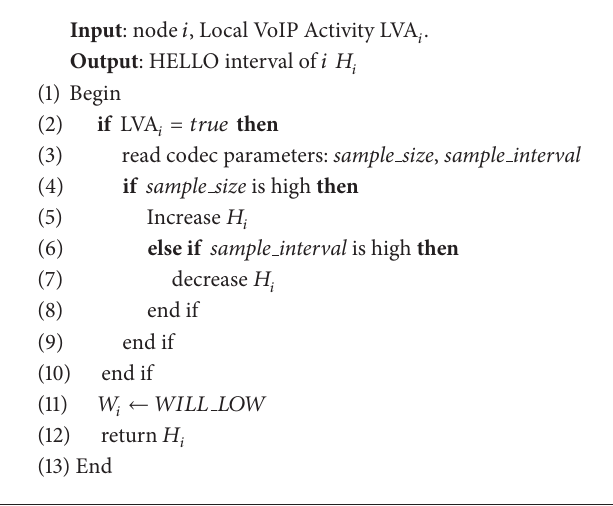
Algorithm 1: OLSR-VA LVA adaptation function( 𝑖 , LVA 𝑖